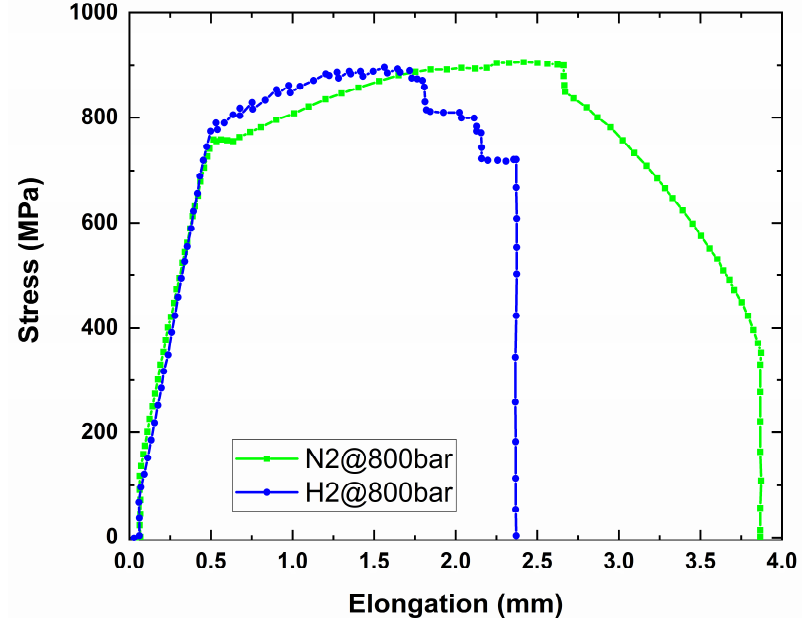
Figure 4. Stress vs. elongation curve in H 2 environment and in N 2 environment.